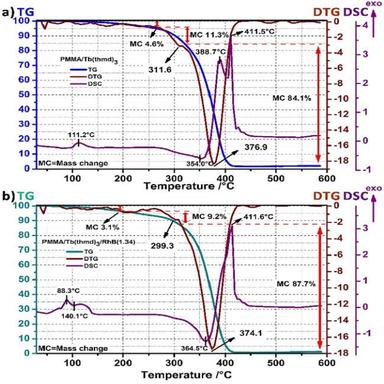
Optical transmission of PMMA pure and doped with Tb(tmhd)3 and RhB. The concentrations of samples A to E are in